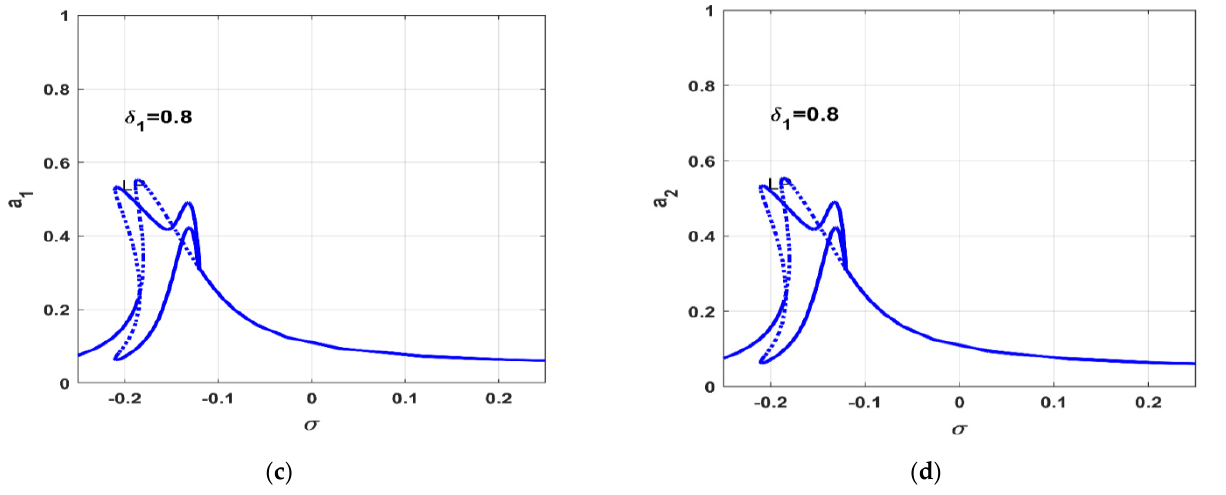
Figure 13. 𝜎 − response curve of the controlled Jeffcott rotor (i.e., 𝐸 = 0.03,𝜆 = 0.05 , and 𝛿 (cid:2870) = Figure 13. σ —response curve of the controlled Jeffcott rotor (i.e., E = 0.03, λ = 0.05, and δ 2 = 0.002) 0.002 ) at two different value of the proportional gain 𝛿 (cid:2869) : ( a , b ) oscillation amplitudes ( 𝑎 (cid:2869) and 𝑎 (cid:2870) ) at two different value of the proportional gain δ 1 : ( a , b ) oscillation amplitudes ( a 1 and a 2 ) versus σ versus 𝜎 when 𝛿 (cid:2869) = 0.85 , and ( c , d ) oscillation amplitudes ( 𝑎 (cid:2869) and 𝑎 (cid:2870) ) versus 𝜎 when 𝛿 (cid:2869) = 0.8 . when δ 1 = 0.85, and ( c , d ) oscillation amplitudes ( a 1 and a 2 ) versus σ when δ 1 = 0.8. To validate the accuracy of the Figure 13, the system equations of motion (i.e.,